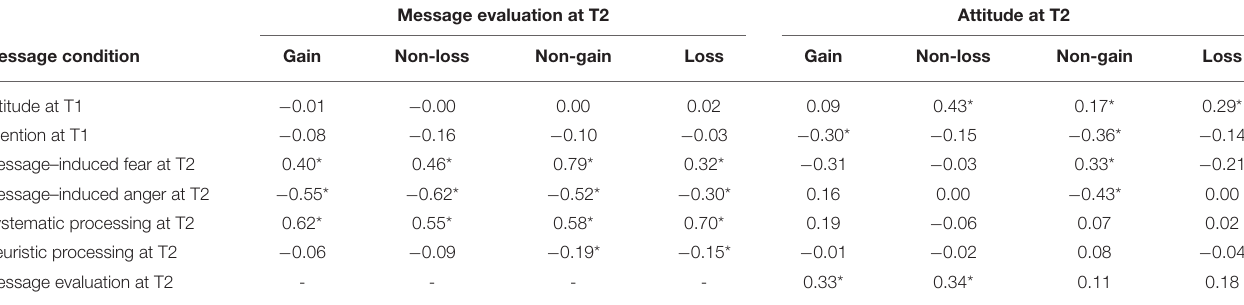
TABLE 2 | Posterior regression estimates of message evaluation and attitude at T2 in the four message conditions. Message evaluation at